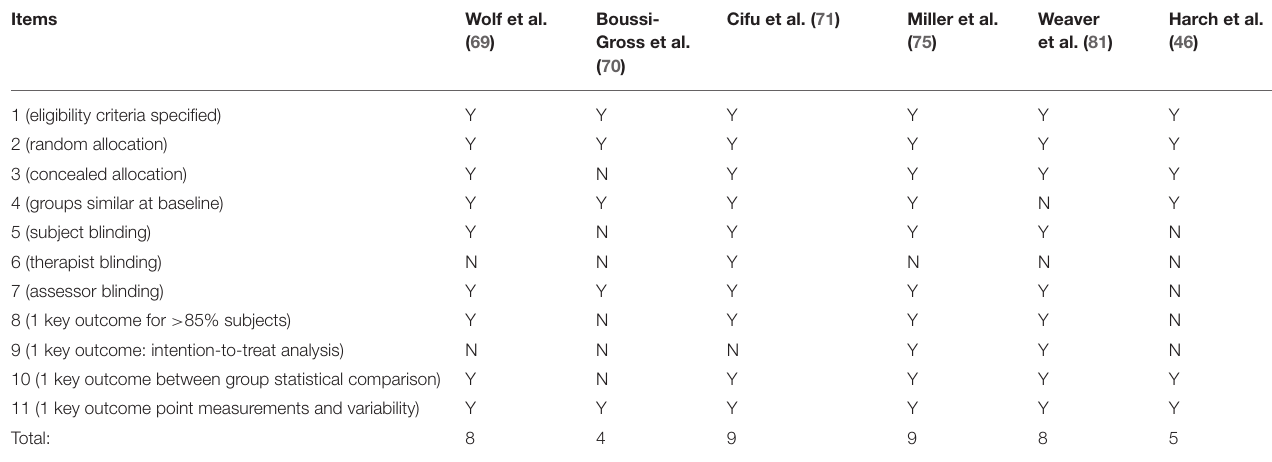
TABLE 6 | PEDro analysis of methodologic quality and bias for randomized trials.